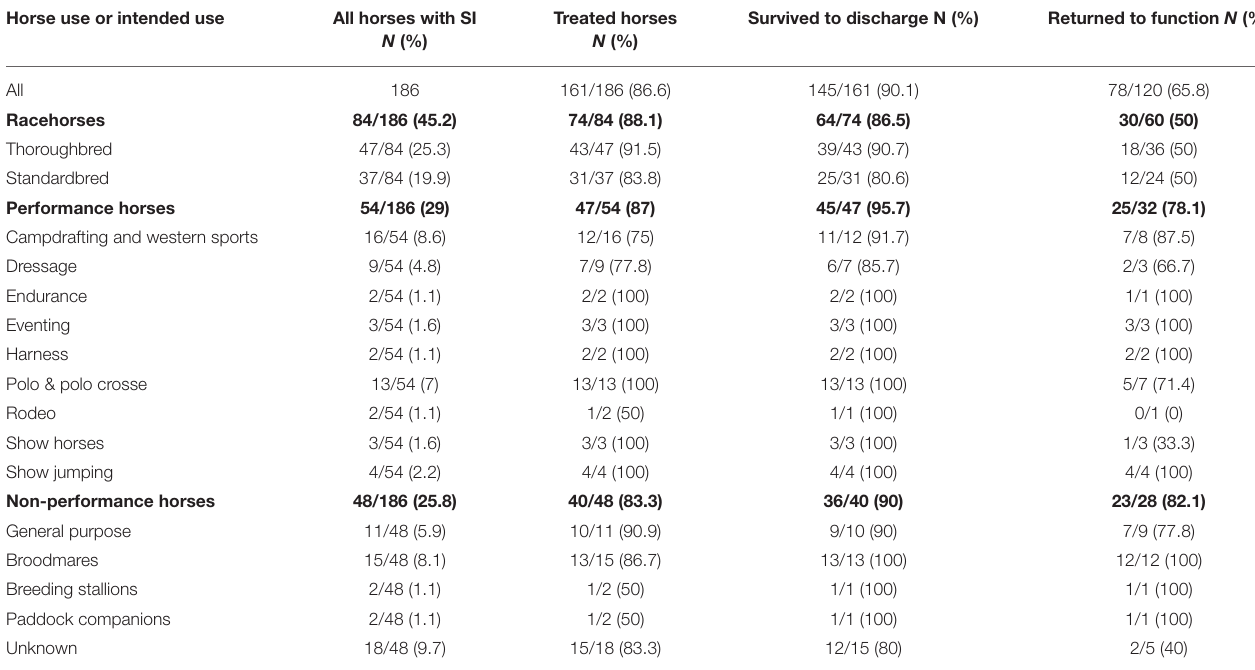
The text in bold refers to the total numbers of horses grouped by differing athletic requirements.